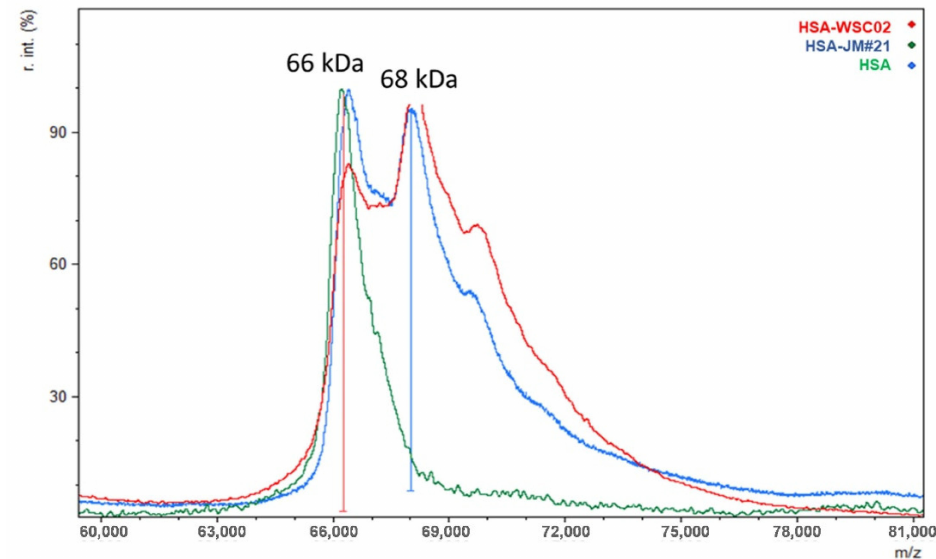
Figure A5. MALDI-FOF-MS (+), sinapinic acid matrix. m/z [M + H] + = 66 kDa (native HSA), [M + H] + = 68 kDa (conjugated